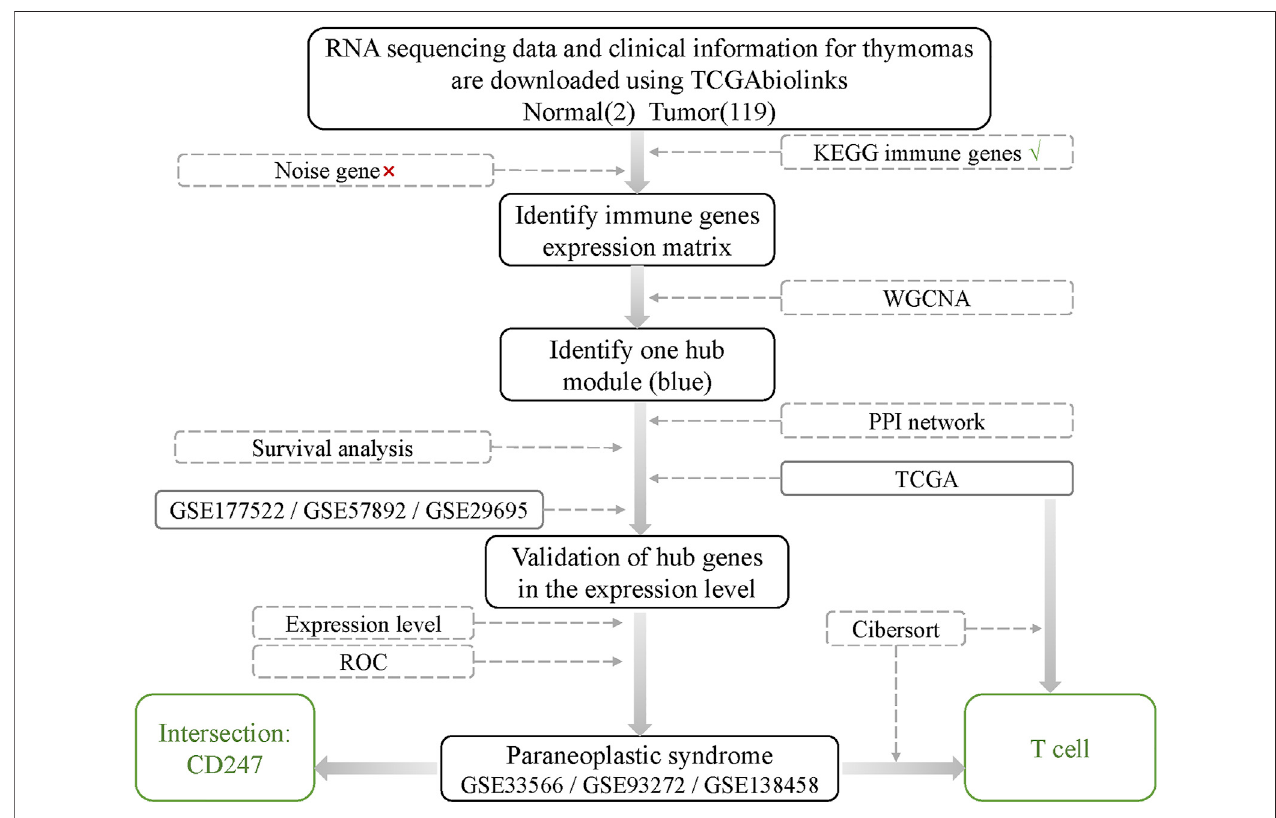
FIGURE 1 | Work fl ow of searching hub genes in